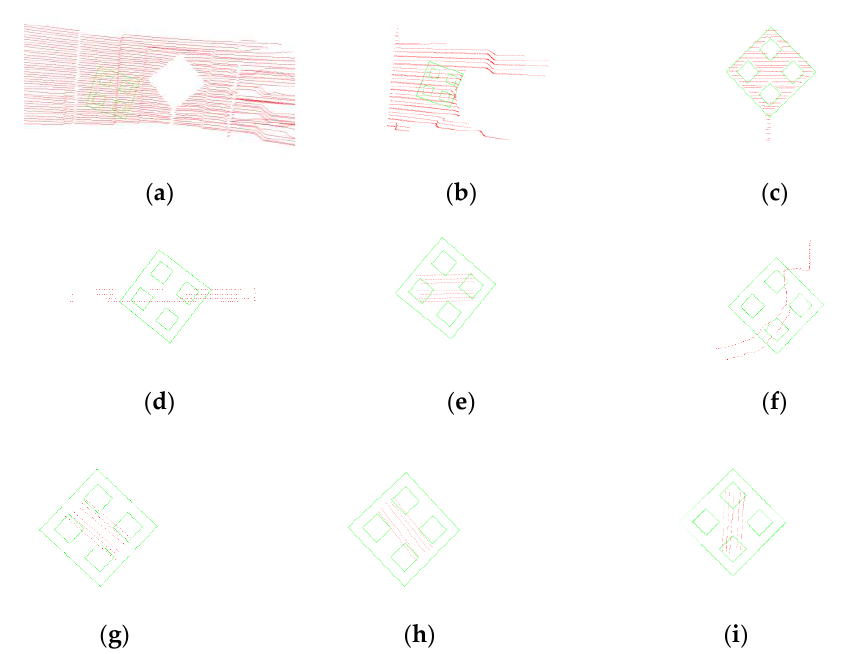
Figure 10. Results of Euclidean clustering when 𝜃 = 0.1° . ( a – i ) are point clouds of different clusters, sorted in descending order according to the number of point clouds. Table 3 . Matching score of different objects.